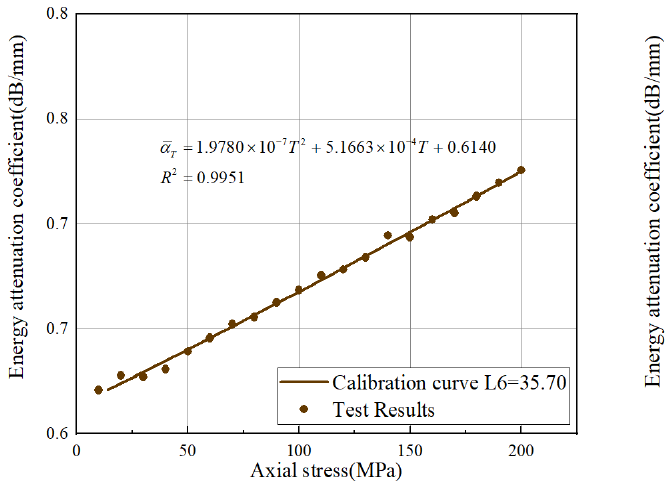
Figure 9. Value of CV in each frequency band.